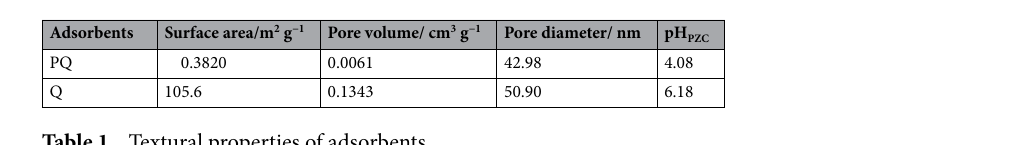
Table 1. Textural properties of